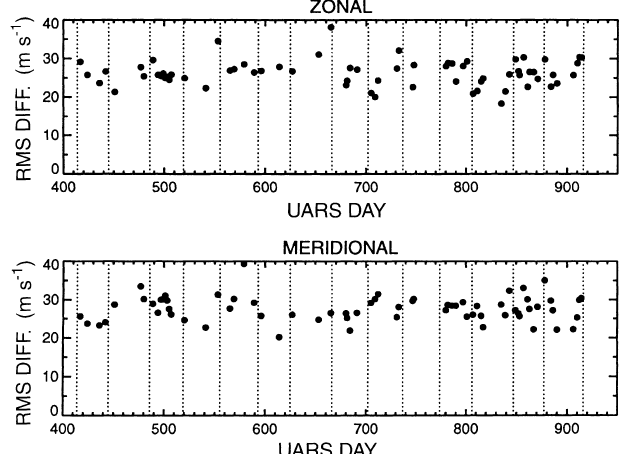
Fig. 13. RMS di(cid:128)erences between the HRDI and WINDII wind data sets at an altitude of 95 km, as a function of time, for the zonal component ( upper panel ) and meridional component ( lower panel )